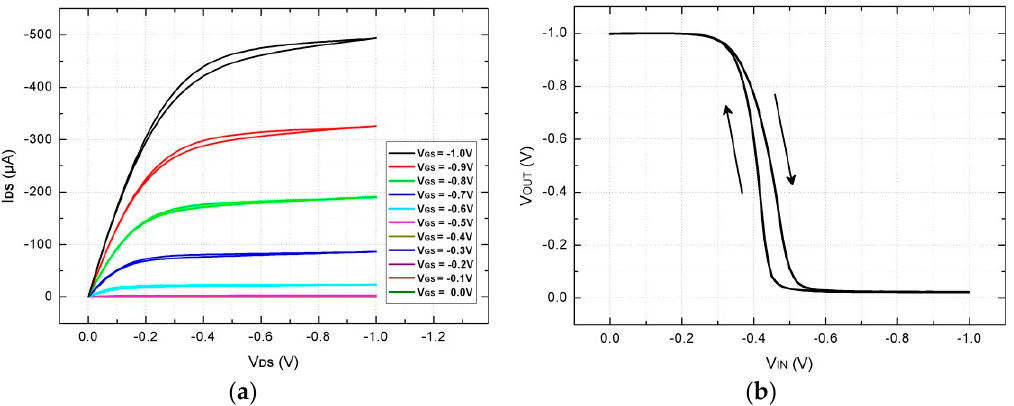
Figure 4. ( a ) I DS vs. V DS curves of WG-FET; ( b ) Voltage transfer curve of